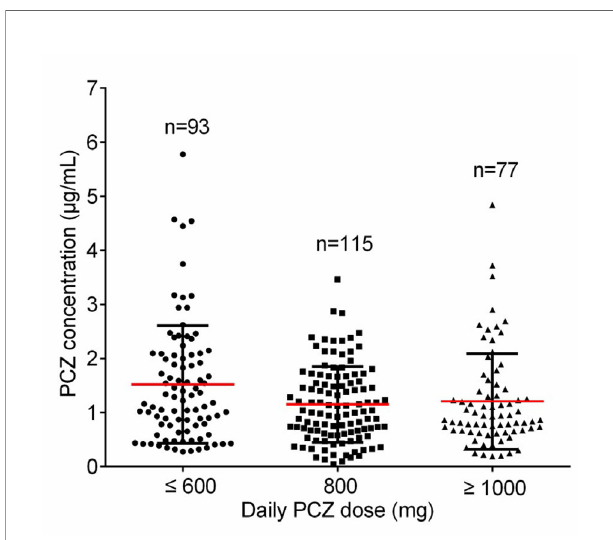
FIGURE 2 | The distribution for PCZ trough concentrations. The horizontal red lines represent the mean value and the lower and upper black lines represent the SD value,